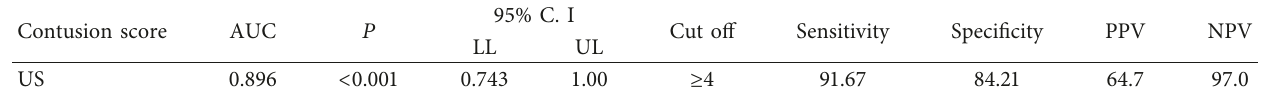
Figure 5: Correlation between CT and US according to lung contusion volume score. R � 0.781. Table 3: Sensitivity and specificity tests for lung contusion score to predict the development of ARDS.